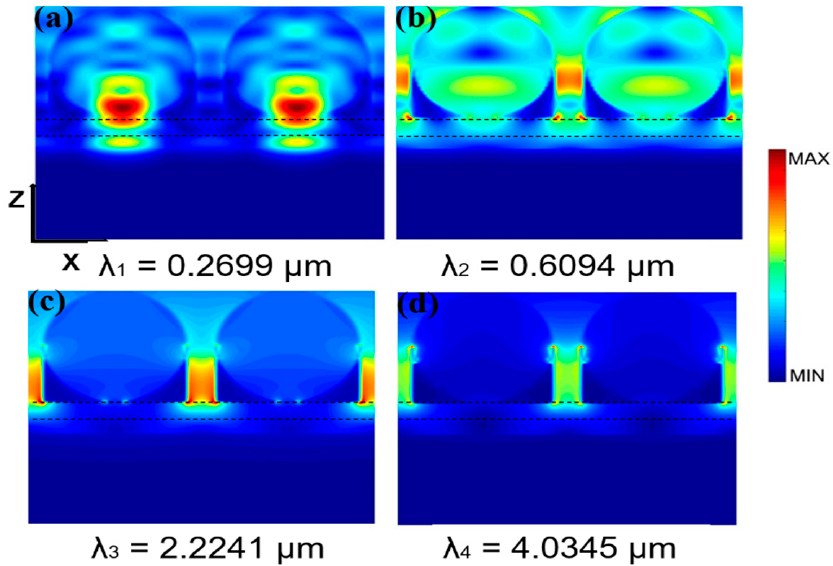
Figure 4. Electric field intensity distribution profiles on the X–Z plane under the excitation of incident light with wavelength of λ 1 ( a ), λ 2 ( b ), λ 3 ( c ), and λ 4 ( d ), respectively.